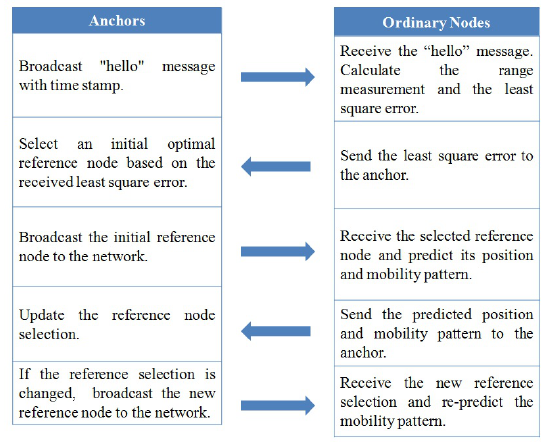
Figure 5. The implementation of DRSL